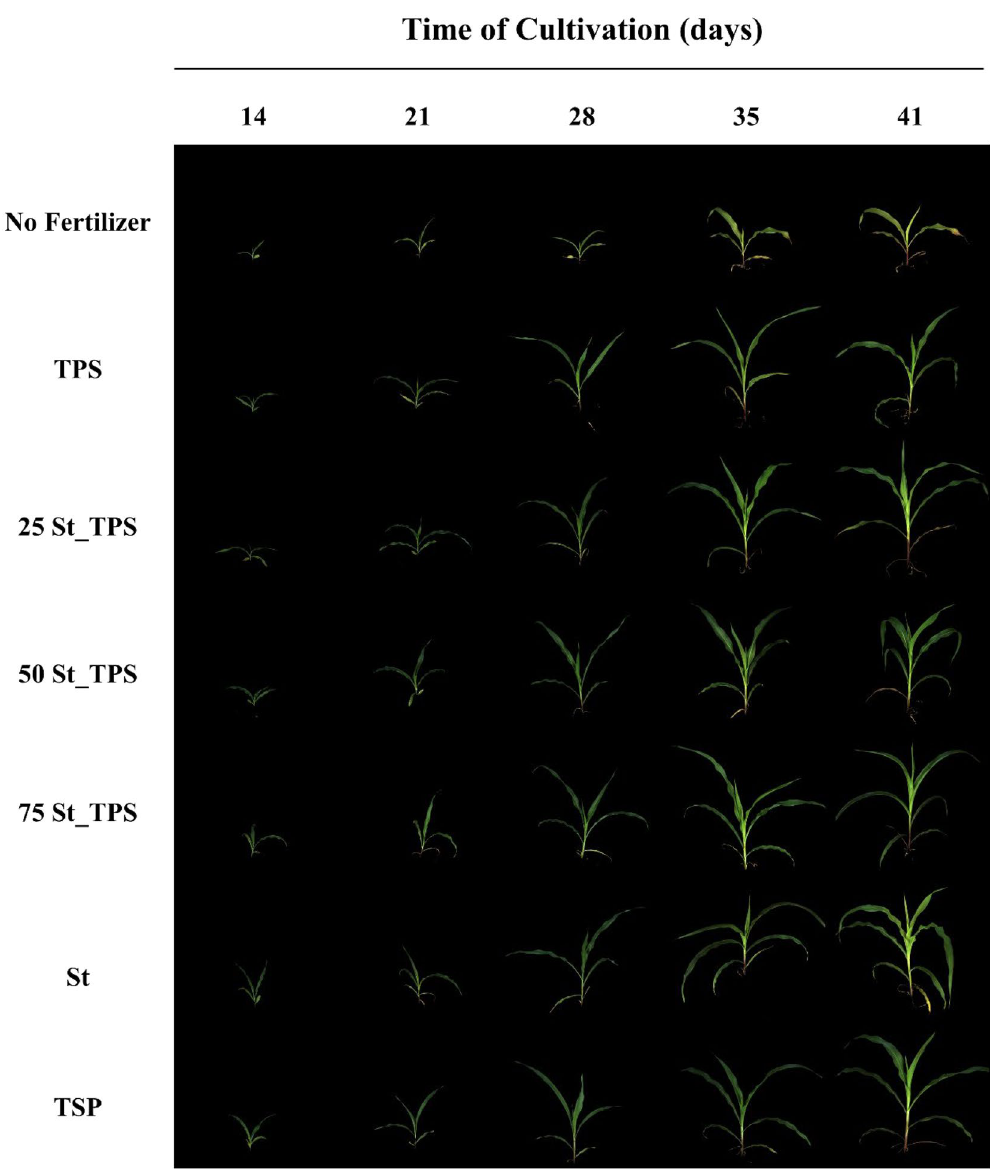
Figure 5. Representative images from maize cultivation over time at a 45° angle, with the no fertilizer control, pure thermoplastic starch (TPS), composites 25 St-TPS, 50 St-TPS, and 75 St-TPS, pure struvite (St), and the positive reference of triple superphosphate